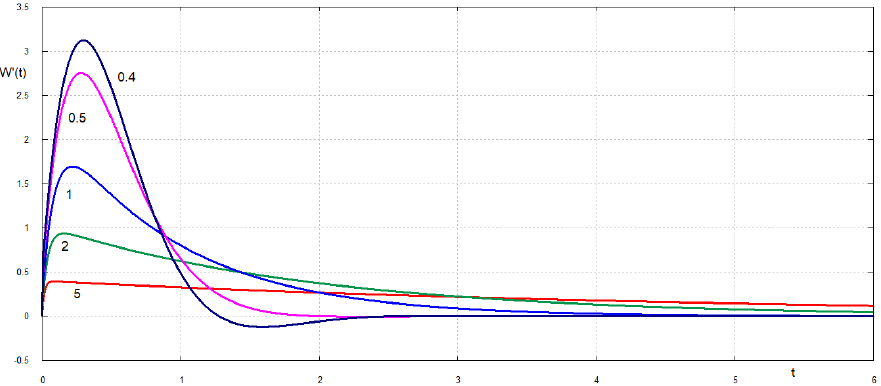
Figure 4. Dimensionless velocity of the plate edge W t ( 0, t ) after the plate breaking t > 0 for large values of the dimensionless retardation time ˜ τ = 0.4,0.5,1,2,5.